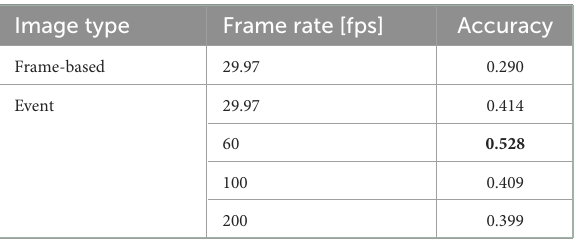
TABLE 2 Isolated single sound recognition